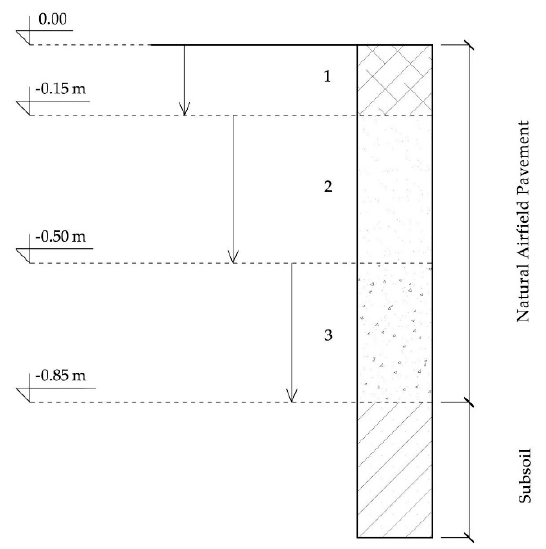
Figure 6. Diagram of the DCP probe and the view of the measurements [42].